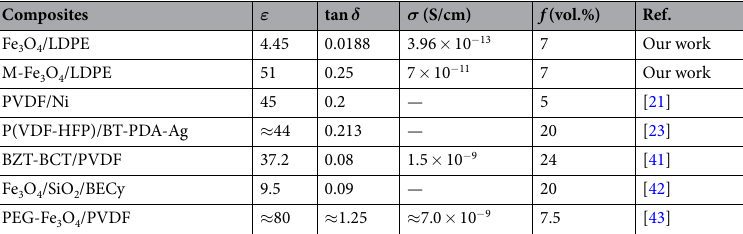
Table 3. Comparison of the dielectric properties of our composites and reported literature